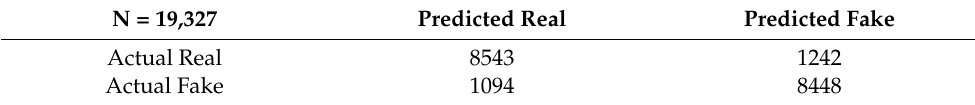
Table 5. Efficient Net confusion